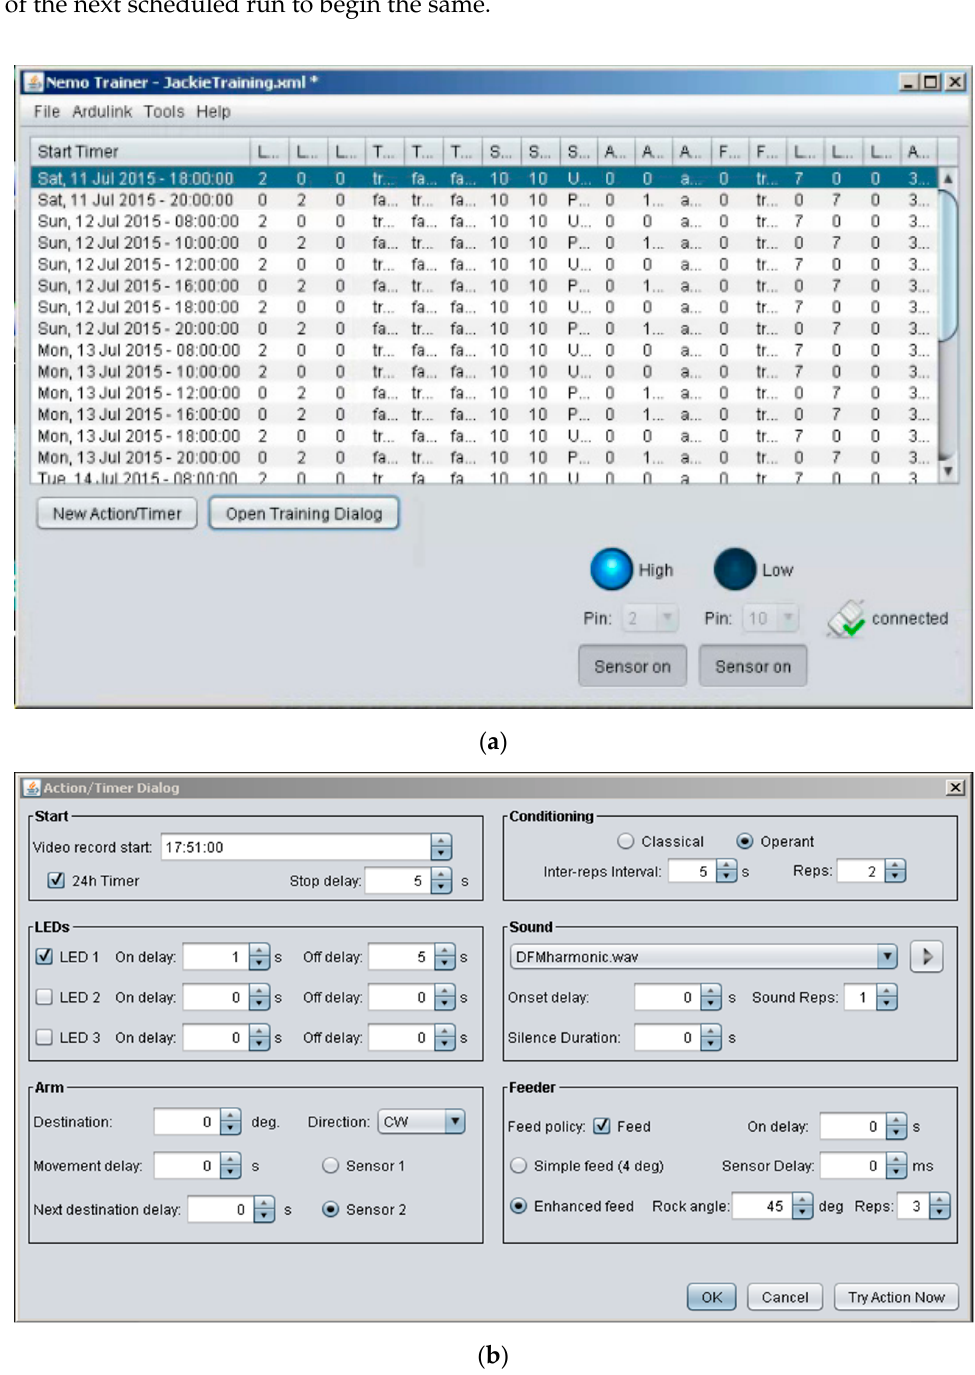
Figure 3. Screen captures of the user interface for the Java facility. ( a ) Scheduler-interface showing the training schedule for communication with Arduino. ( b ) Computer interface for monitoring sensors and control of associative conditioning. User-definable settings enable either classical or operant conditioning via customized multi-day scheduling and precise control of stimulus parameters for training.